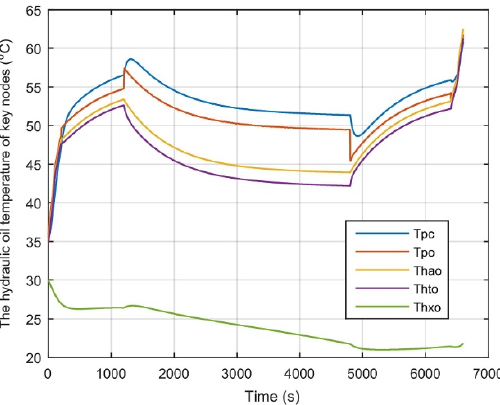
Figure 8. Temperature change at five key nodes of hydraulic system under a full mission profile.